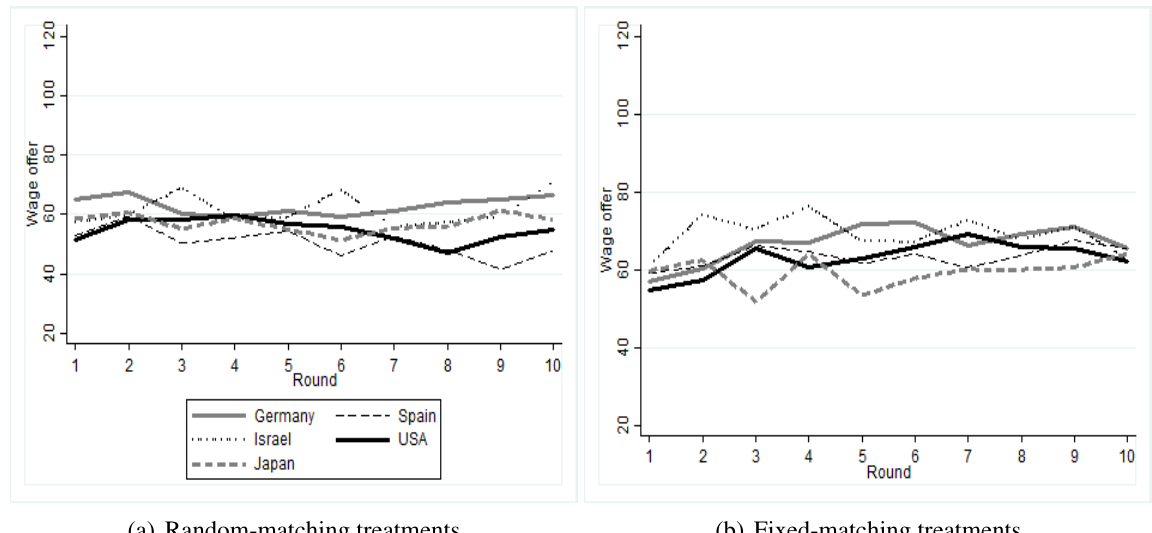
Figure B1. Evolution of average wages in the random- and fixed-matching treatments.